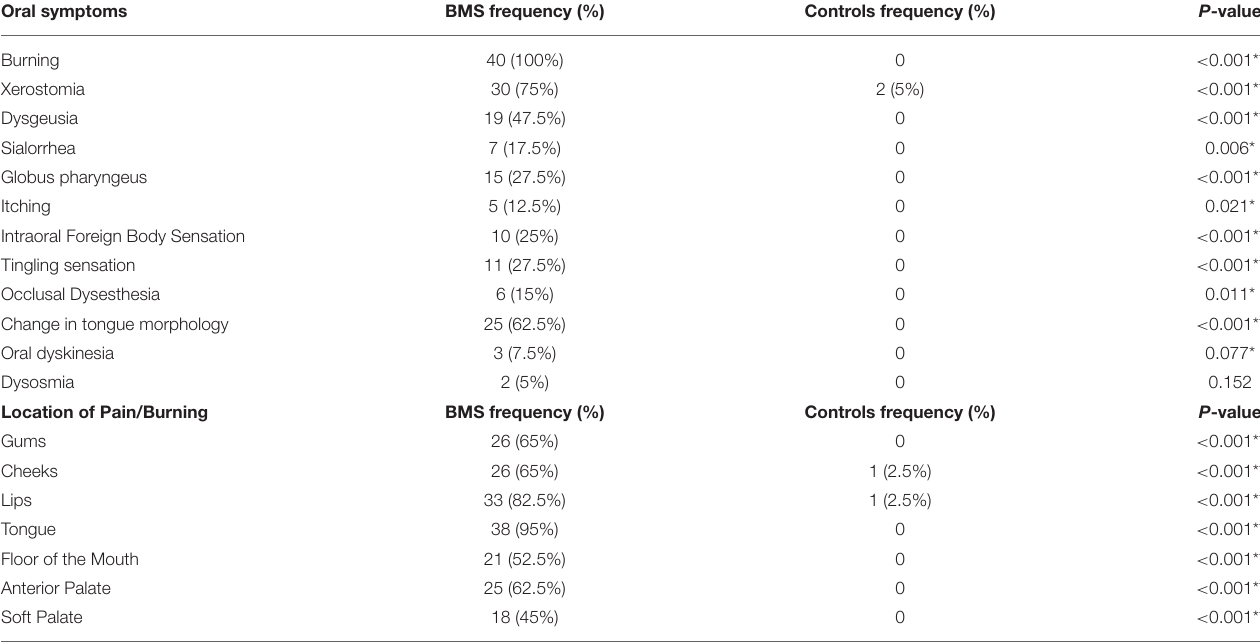
TABLE 3 | The prevalence of oral symptoms and sites involved in patients with BMS and control subjects.